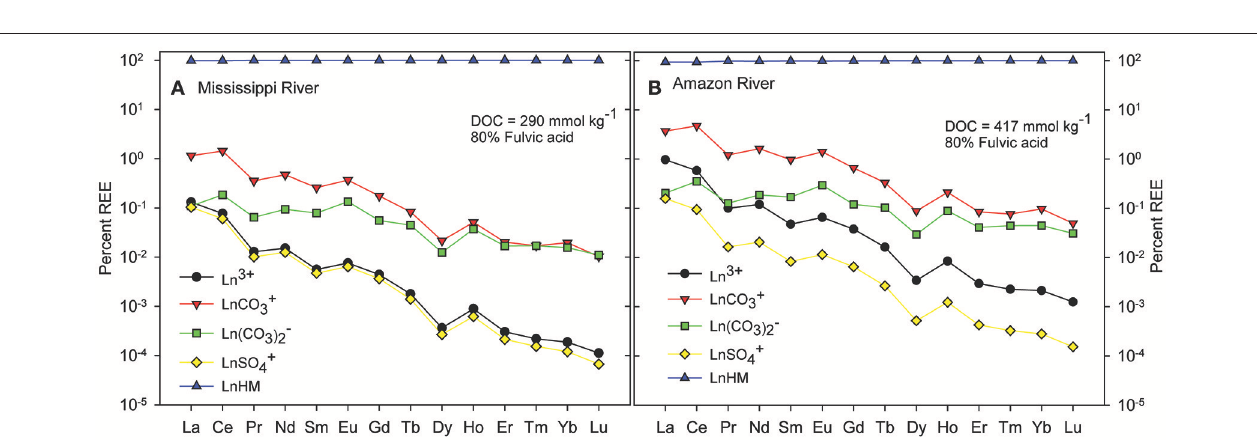
FIGURE 5 | Solution complexation modeling (WHAM VII) results for (A) the Mississippi River water, and (B) the Amazon River water, where Ln represents individual REE, and HM represents humic material. Note that the ordinate scales are